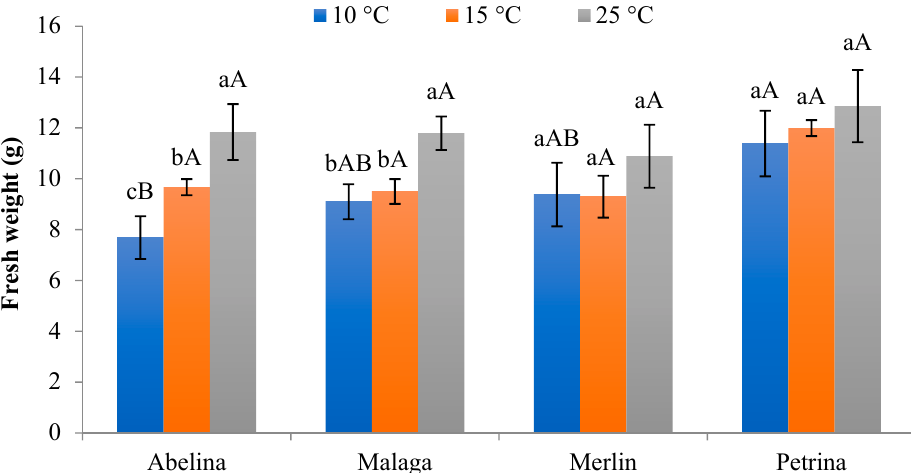
Figure 5. Fresh weight of aboveground parts in four soybean cultivars grown for the first seven weeks from the seeds germinated for 48 h at different temperatures. Values represent means ( n = 20) ± SE. The values for each cultivar followed by the same lowercase letter do not differ significantly, while means for the same temperature marked with the same uppercase letter do not differ significantly according to Duncan’s multiple range test ( p < 0.05).